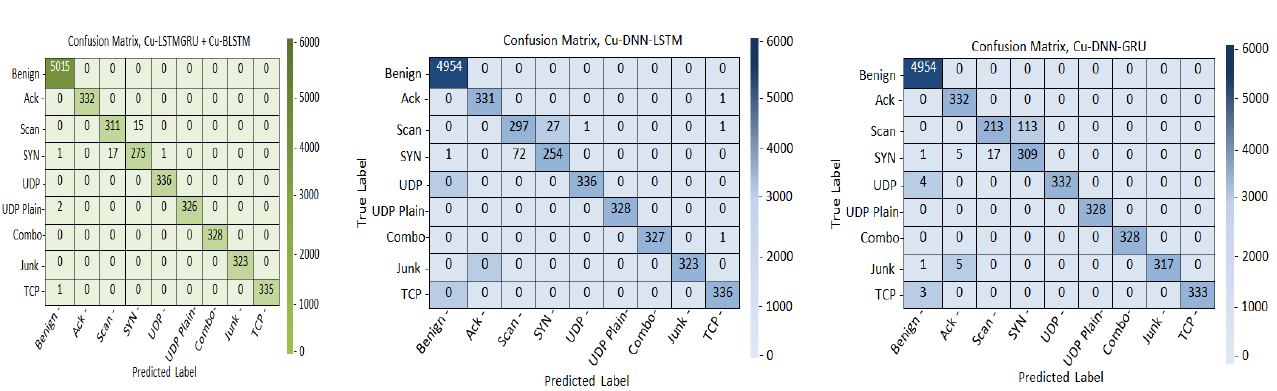
Figure 4. Confusion metrics of the